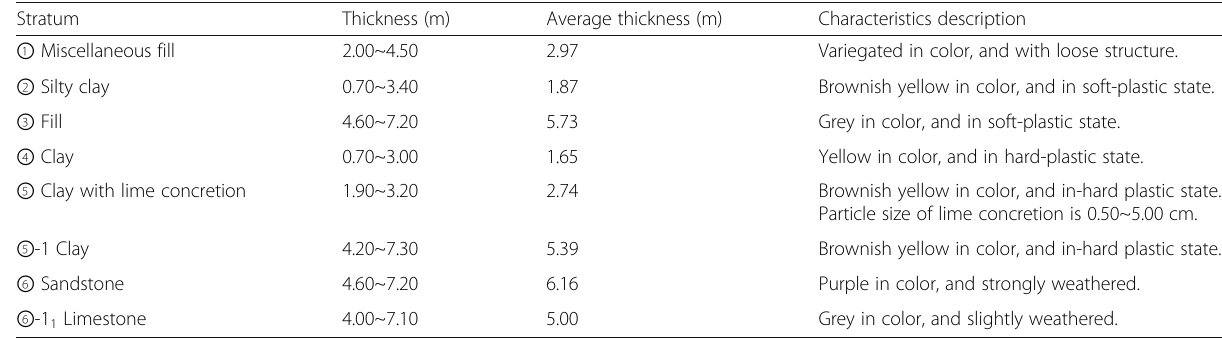
Table 1 Characteristic of the stratums in construction